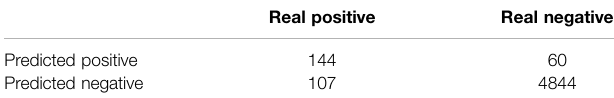
TABLE 2 | Confusion matrix of the baseline predictor.